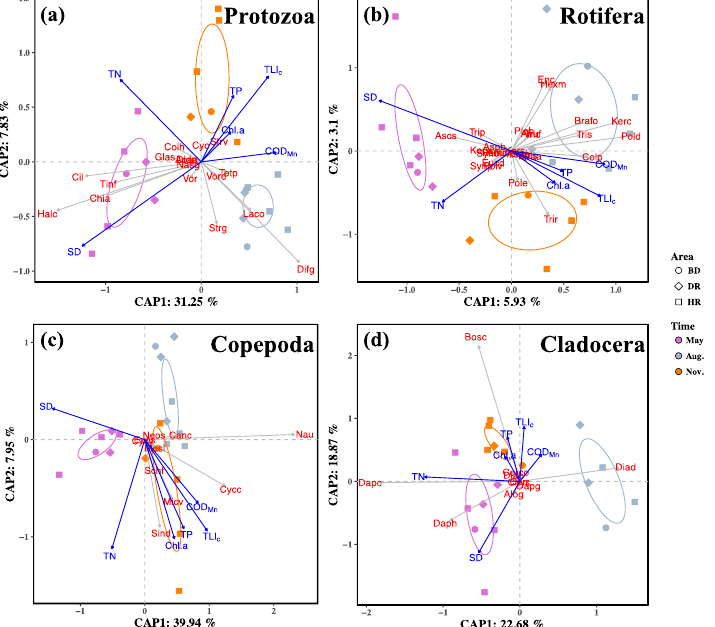
Figure A2. Plots of distance-based Redundancy Analysis (db-RDA) on the relationships between each taxonomic group (based on the abundance data) and environmental parameters (scaling = 2). Confidence intervals for the sites in different sampling months are represented by the ellipses (confidence level: 0.95). ( a ) Protozoa, ( b ) Rotifera, ( c ) Copepoda, ( d ) Cladocera. SD: Secchi disk depth, Chl. a : chlorophyll a , TN: total nitrogen, TP: total phosphorus, COD Mn : permanganate index. HR: Hanjiang reservoir area, DR: Danjiang reservoir area, BD: the area close to the dam. The full names of taxa codes are listed in Table